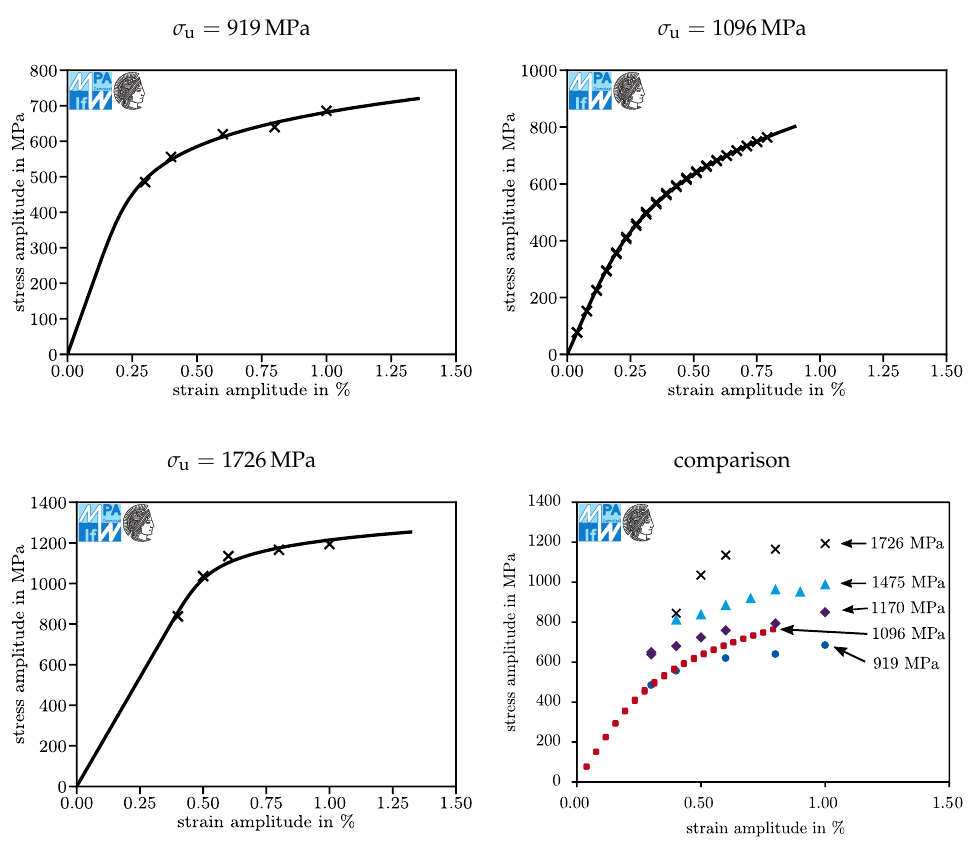
Figure 6. Cyclic stress strain curves. ( First row ): 919MPa and 1096MPa ultimate tensile strength. ( Second row ): 1726MPa ultimate tensile strength (left) and comparison of batches with 919MPa, 1096MPa, 1170MPa, 1475MPa and 1726MPa ultimate tensile